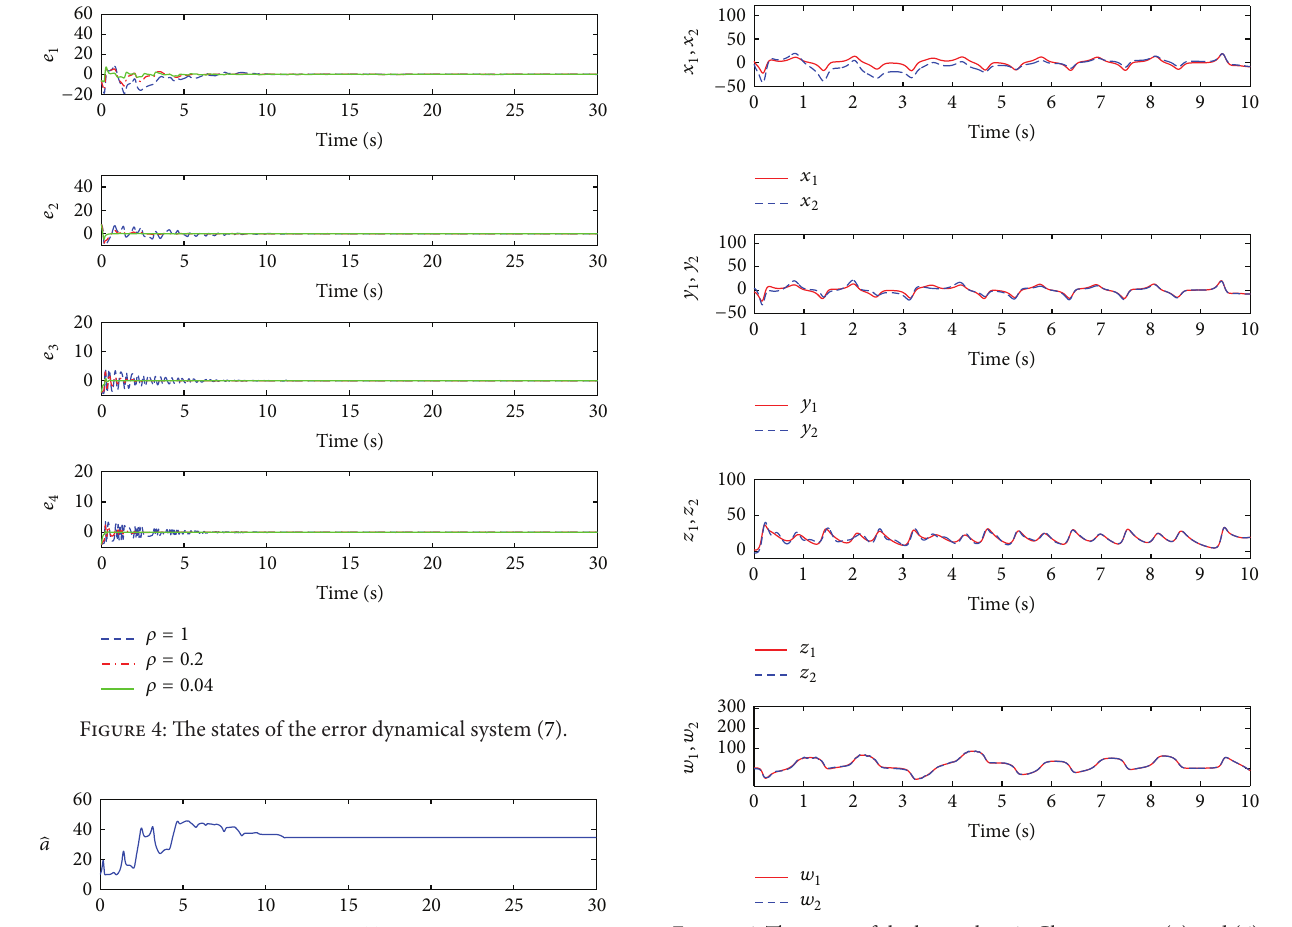
Figure 6: The states of the hyperchaotic Chen systems (5) and (6).